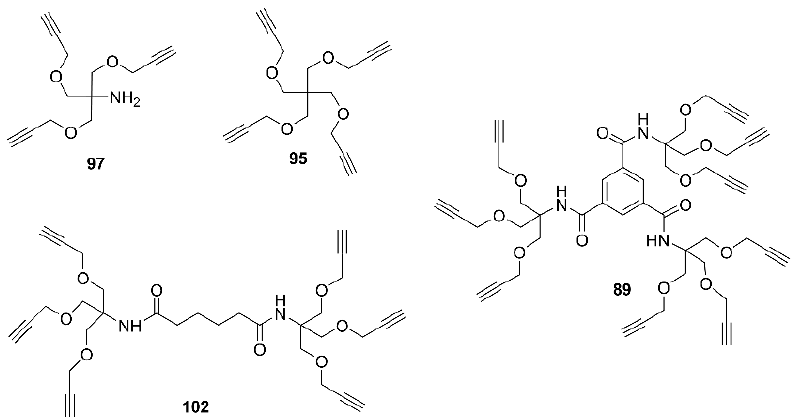
Figure 8 . Alkynyl scaffolds for CuAAC reaction. Figure 8. Alkynyl scaffolds for CuAAC reaction.